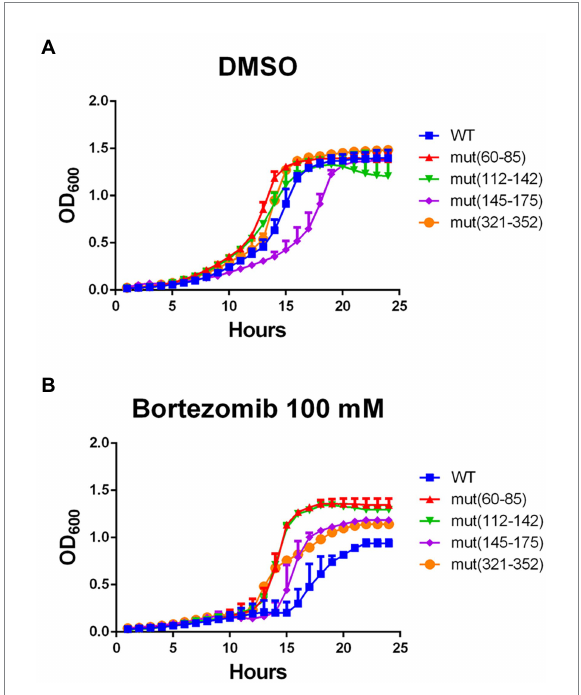
FIGURE 5 Response to the proteasome inhibitor bortezomib is improved by synonymous mutations in pgk1 . Yeasts were incubated with vehicle (DMSO) (A) or 100 μ M bortezomib (B) in EMM2 for 24 h in standard conditions. Blue squares, red triangles, green inverted triangles, purple diamonds, and orange circles represent WT, mut(60–85), mut(112–144), mut(145–175), and mut(321–352) respectively. Growth was monitored by recording OD 600 at each hour.